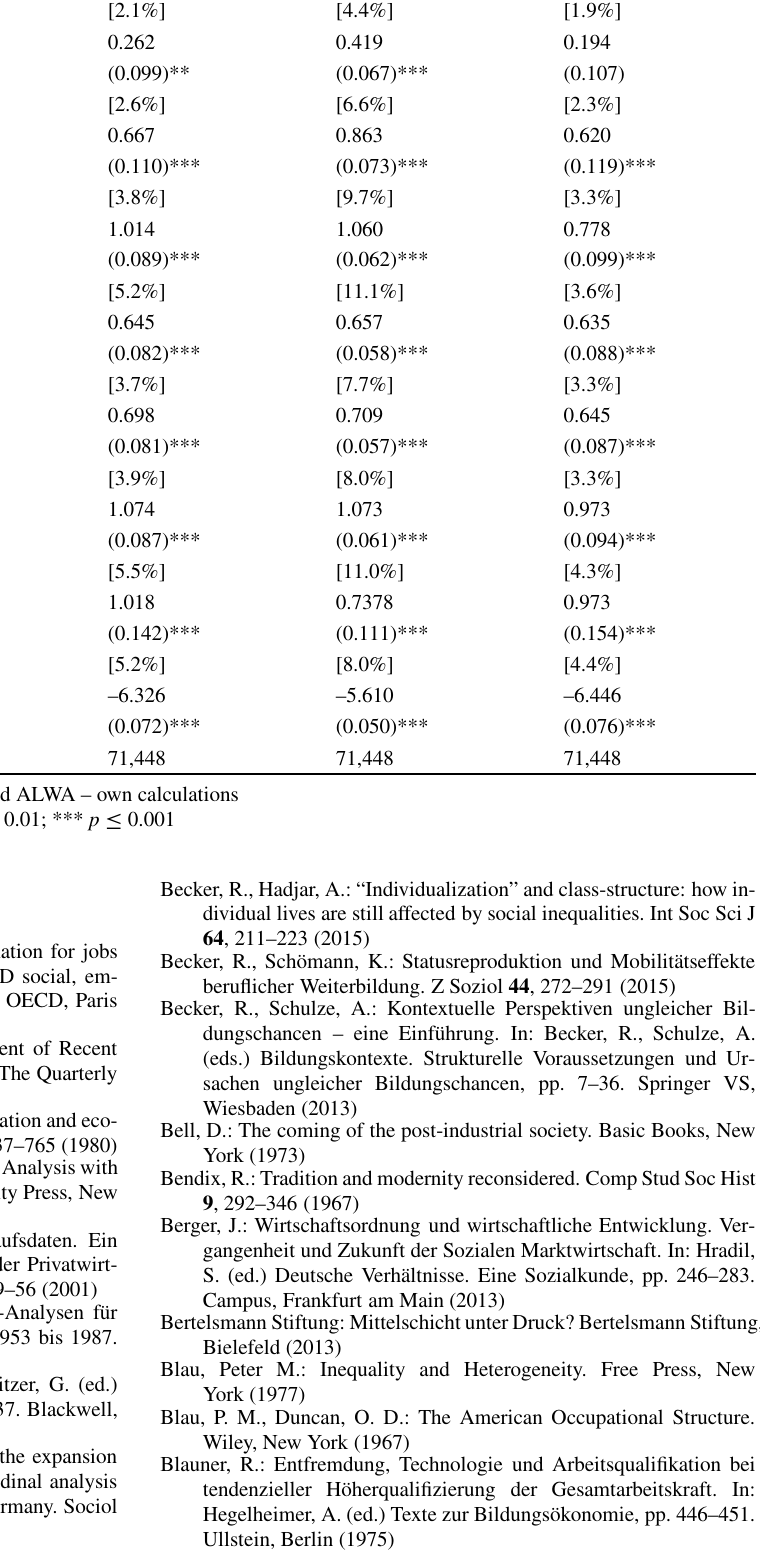
Table 6 Mobility patterns across birth cohorts for West German men only (in brackets: mobility rate in